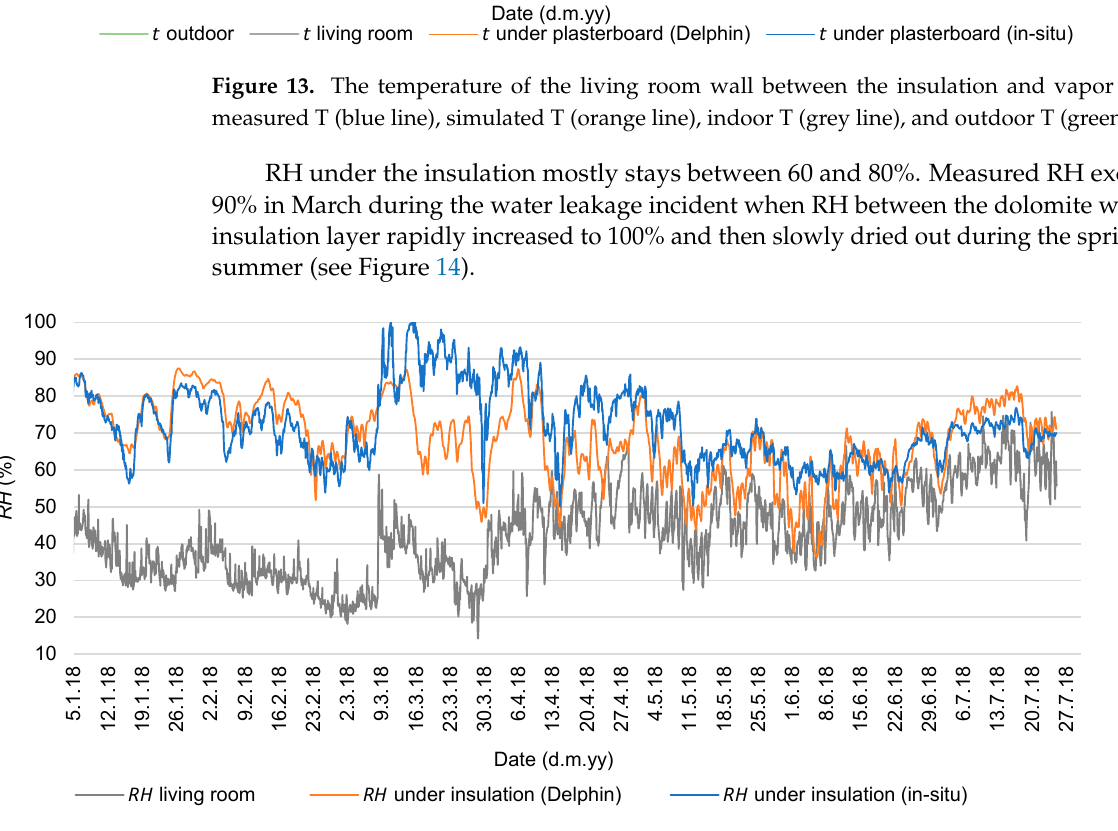
Figure 14. Relative humidity of the living room wall between dolomite and the insulation layers: measured RH (blue line), simulated RH (orange line), indoor RH (grey line), and outdoor RH (green line).